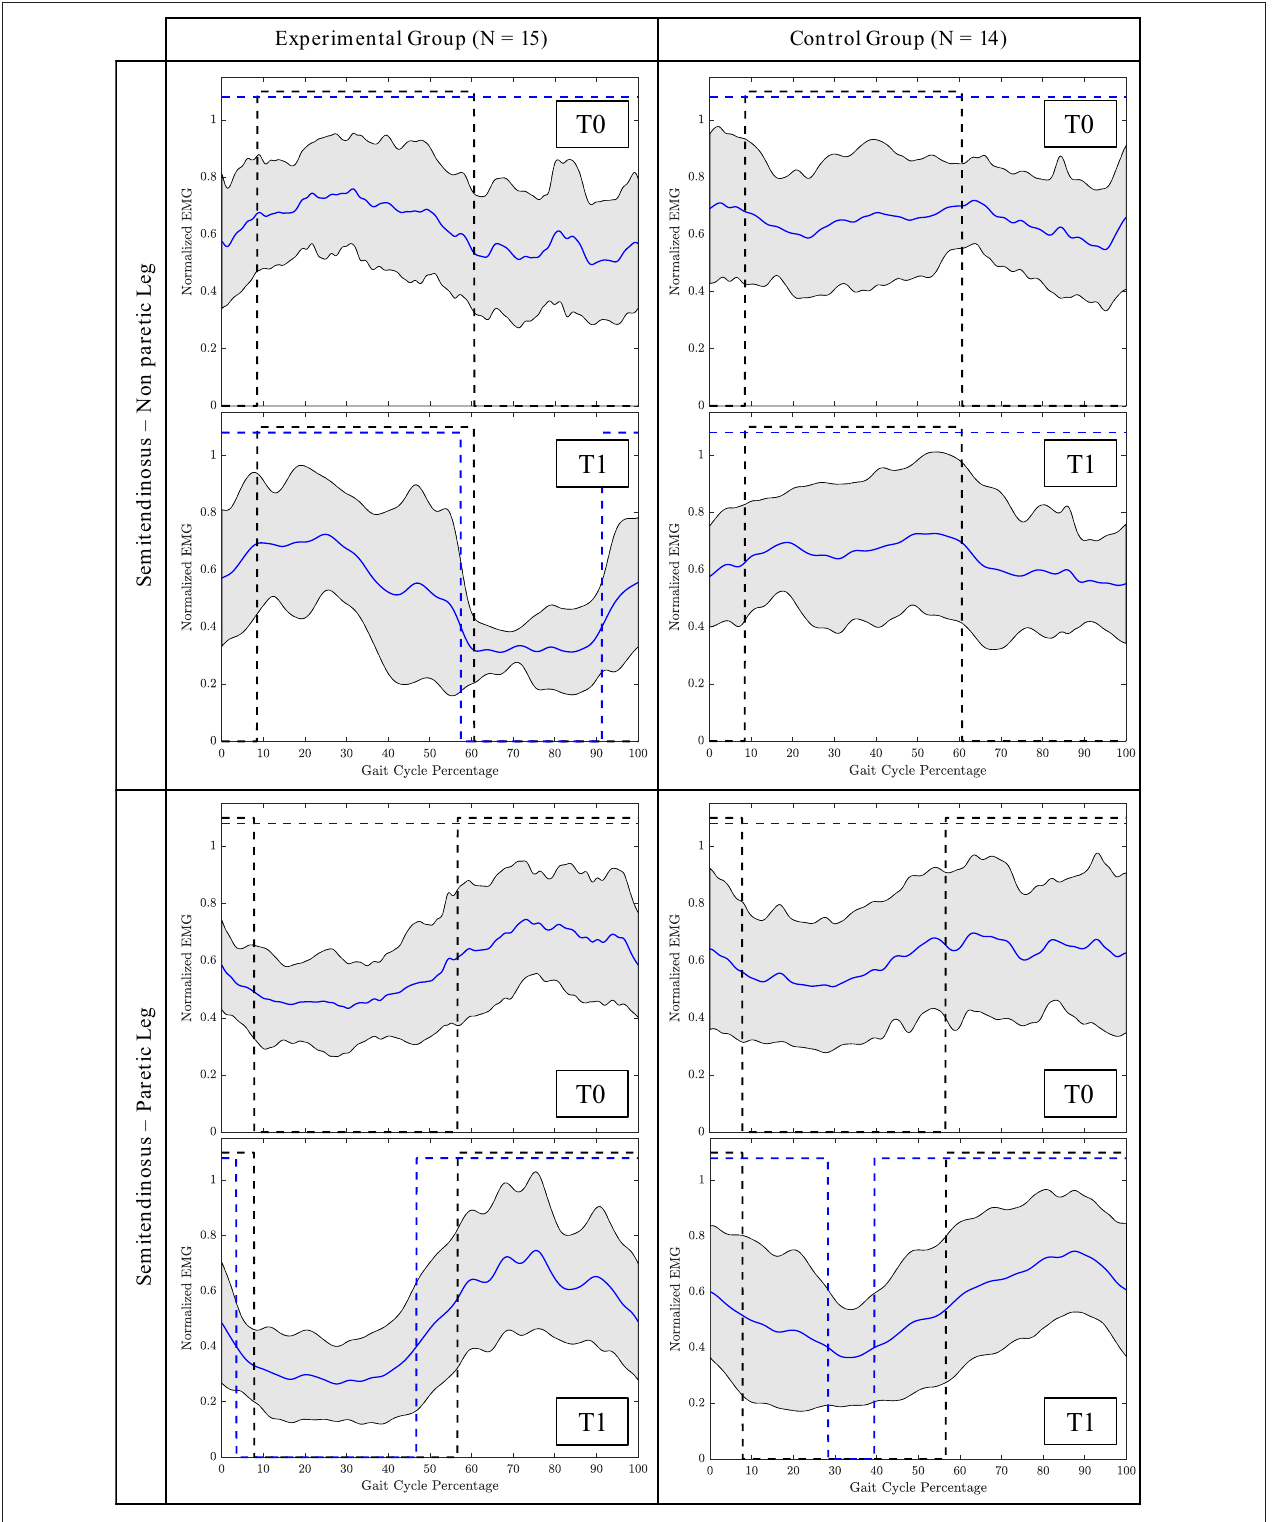
FIGURE 2 | Mean gait cycle of the Semitendinosus (ST) muscle before the intervention (T0) and after the intervention (T1). Blue line = Mean patients’ activation; Grey area = Patients’ SD; Black dashed line = Normative activation profile; Blue dashed line = Patients’ activation profile (active/non-active muscle window). Profile are represented as a function of the gait cycle. In the non-paretic leg, the gait cycle starts from the toe off, in the paretic leg, it starts from the loading response phase.